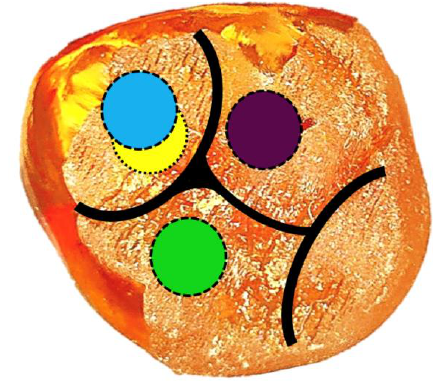
Figure 2. The locations of each di ff erent PEAC of Figure 1 are represented on the occlusal surface of the tooth with the same